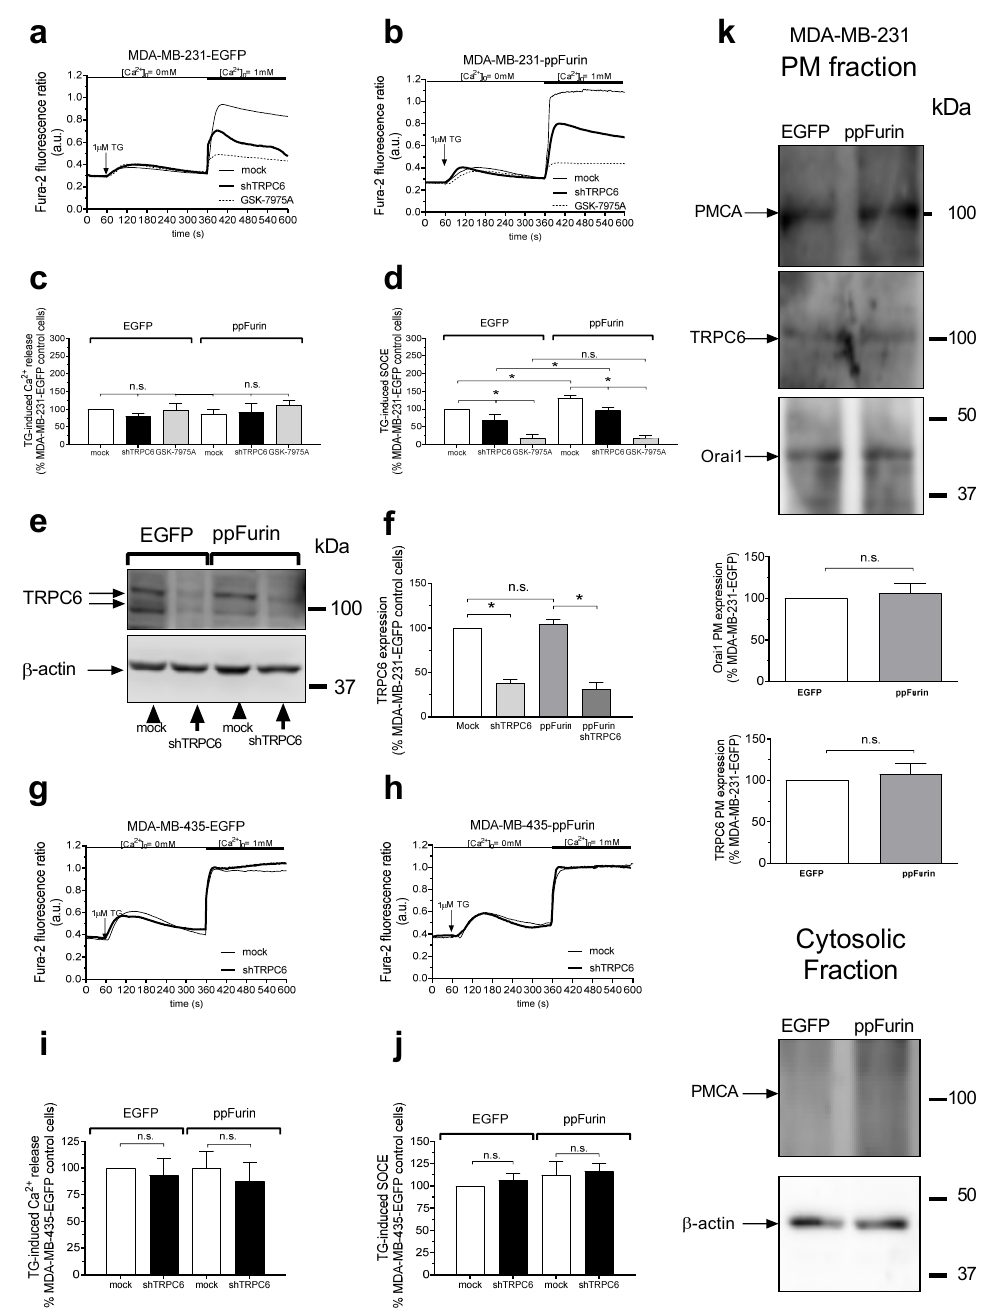
Figure 5. Orai channels play a relevant role in the enhanced SOCE induced by ppFurin in MDA-MB-231 cells. Control ( a , c ) and ppFurin-expressing MDA-MB-231 cells ( b , d ) were either transfected with shTRPC6 or scramble plasmid or pretreated for 1 min with 10 µ M GSK-7975A. Later, cells were loaded with Fura-2 and perfused with a Ca 2+ -free medium (100 µ M of EGTA added). Ca 2+ store depletion was triggered by the stimulation of the cells with 1 µ M of TG, and later 1 mM of Ca 2+ was added to the extracellular medium to initiate SOCE. Traces are representative of 40 cells/day/3–5 days. Bar graphs indicate TG-evoked Ca 2+ release and Ca 2+ entry, as indicated, as the area under the curve, expressed as the mean ± SEM and presented as the percentage of the control (MDA-MB-231-EGFP control cells). Statistical significance was assessed by Student’s t -test and * represents p < 0.05 as compared to the corresponding control. ( e , f ) Control and ppFurin-expressing MDA-MB-231 cells were transfected with shTRPC6 or scramble plasmid and 48 h later were lysed. TRPC6 and β -actin expression were determined by Western blotting as described in the Material and Methods section. Bar graphs represent TRPC6 expression under the different experimental conditions. Data are expressed as mean ± SEM. Statistical significance was assessed by Student’s t -test and * represents p < 0.05 as compared to the corresponding control. Control ( g , i ) and